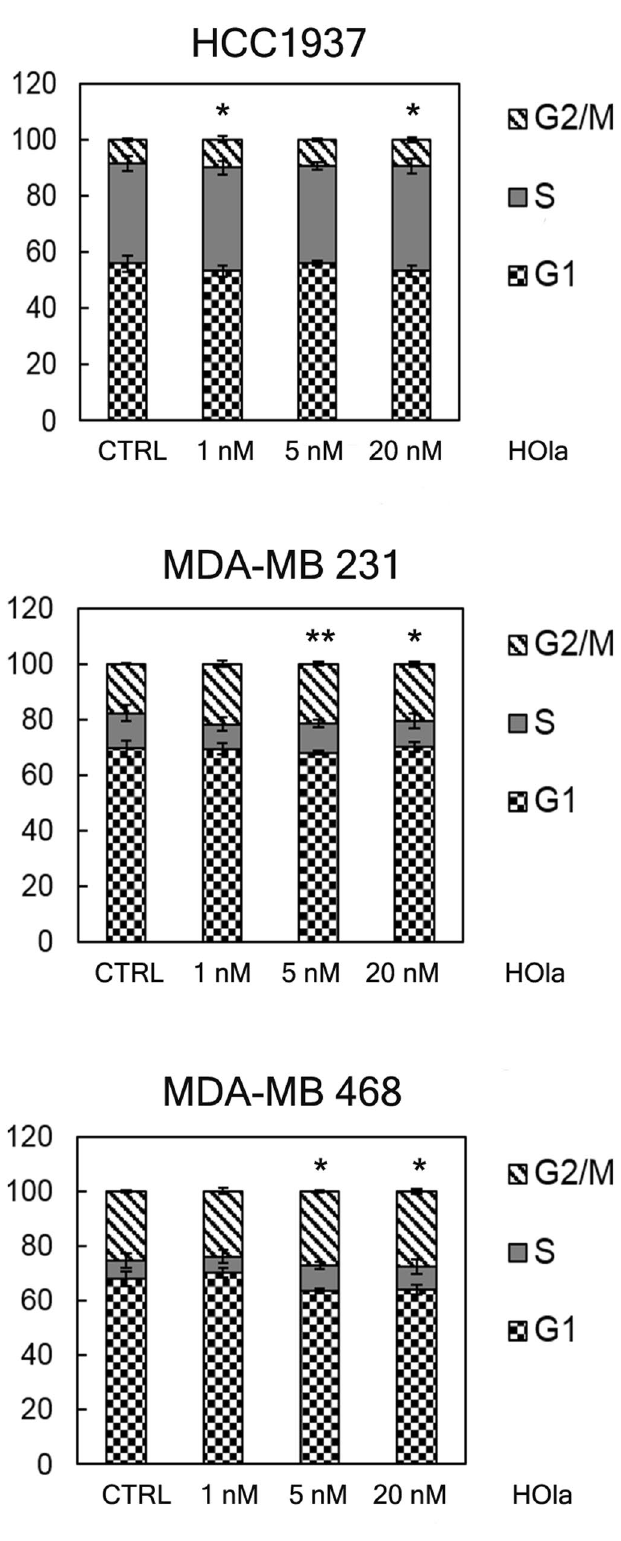
Figure 5. Treatment with HOla causes a cell cycle arrest in G2/M phase. HCC1937, MDA-MB 231 and MDA-MB 468 cells were incubated at 37 °C for 24 h with 1, 5 and 20 nM of HOla. Then cells were processed for flow cytometry and stained with Propidium Iodide. Untreated cells have been used as controls. Graphs represented the mean percentage of events in G1, S and G2/M phase, respectively ± s.e. (n = 3). Statistical significance of HOla vs . CTRL, * P < 0.05; ** P < 0.01 (Student’s t